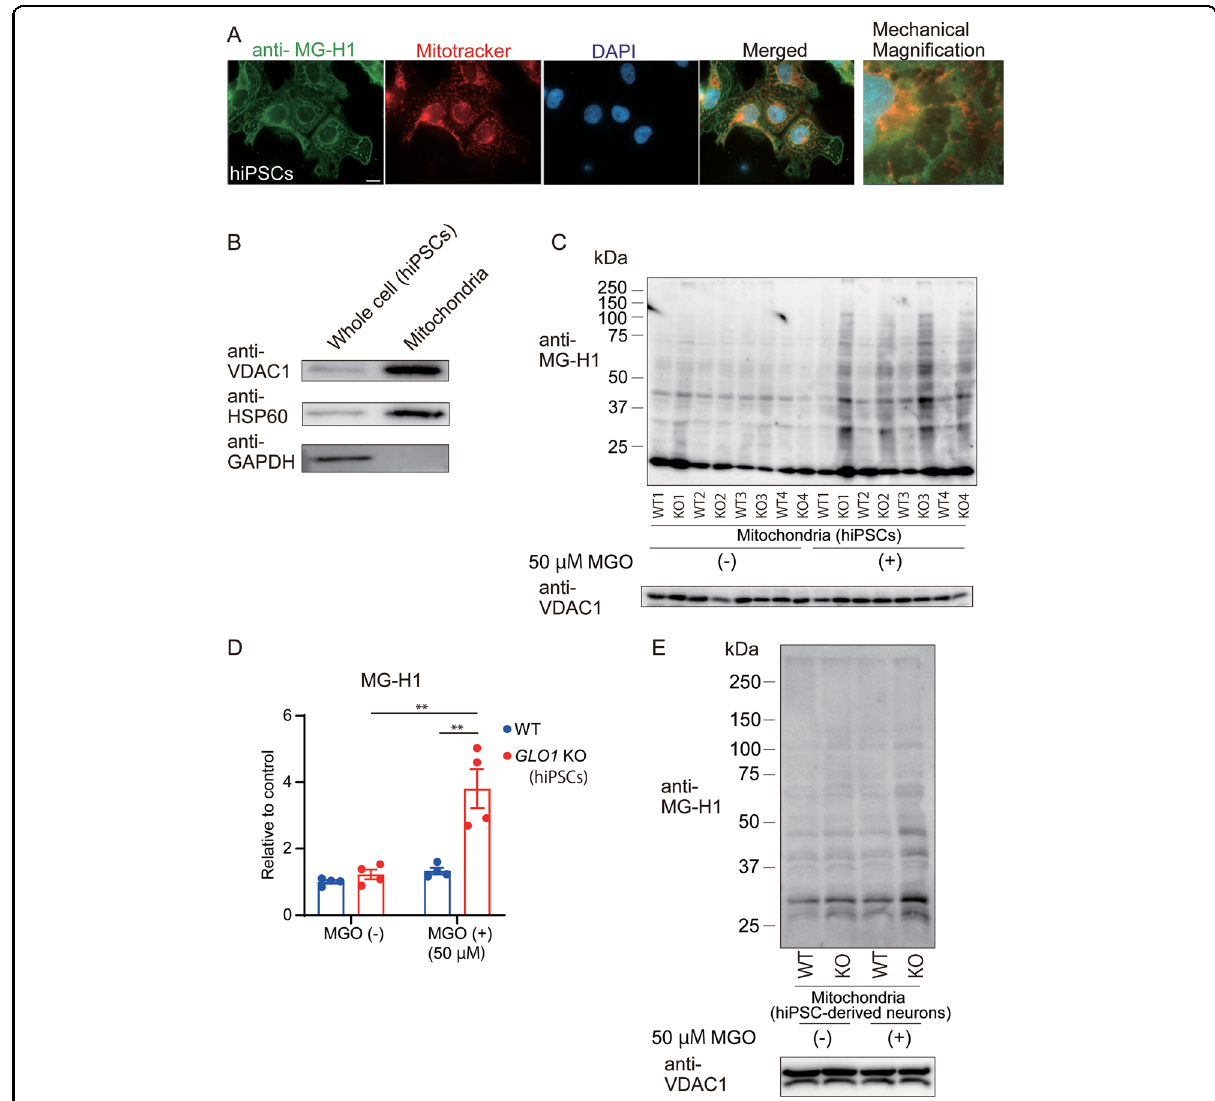
Fig. 5 Deposition of MG-H1 and mitochondrial proteins in mitochondria from WT and GLO1 KO cells. A Immuno fl uorescence images of MG- H1 (green) in mitochondria labeled with Mitotracker ® (red) in WT-hiPSCs (scale bar: 20 µm). MG-H1 immuno-positive staining was partially localized in mitochondria. B Representative Western blot for VDAC1, HSP60, and GAPDH in lysates from whole cell and isolated mitochondria. C Western blotting for MG-H1 and VDAC1 in mitochondria isolated from WT- and GLO1 KO-hiPSCs after treatment with 50 µM MGO for 72 h. D Densitometric analysis of the Western blot shown in C . Signi fi cant increase in MG-H1 modi fi cation was observed in mitochondria from GLO1 KO-hiPSCs after treatment with 50 µM MGO. E Western blotting for MG-H1 and VDAC1 in mitochondria isolated from WT- and GLO1 KO-derived neurons after treatment with 50 µM MGO for 24 h. Mitochondria from GLO1 KO-derived neurons showed increase in MG-H1 modi fi cation upon MGO exposure. Data represent mean ± SEM. ** P < 0.01; two-way ANOVA, followed by Tukey ’ s multiple comparison